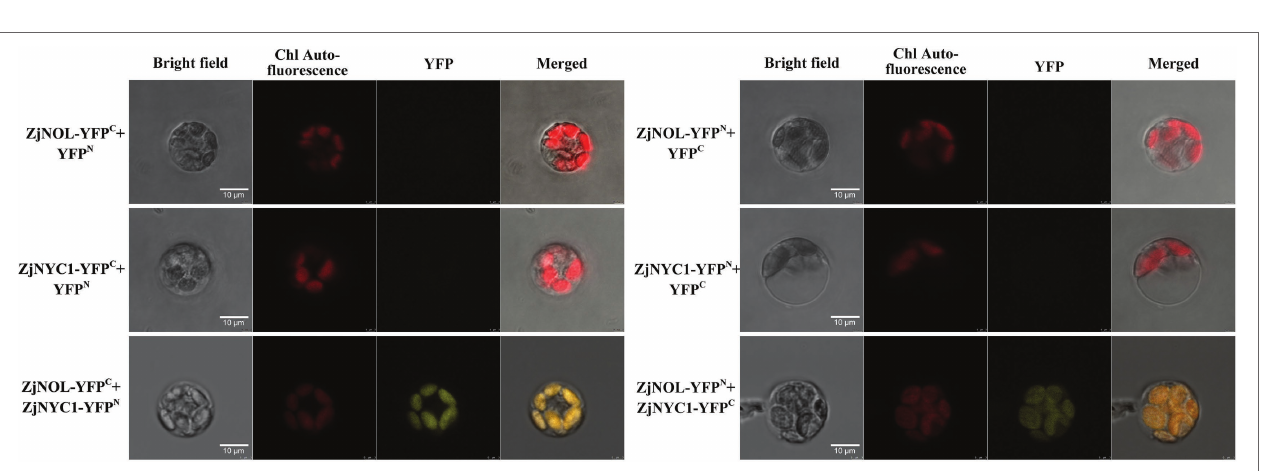
FIGURE 5 | BiFC analysis of the interaction between ZjNYC1 and